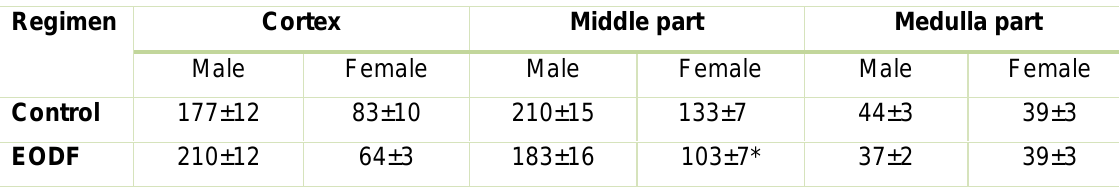
Table 1: The effect of every-other-day fasting (EODF) regimen on the activities of aconitase (mU/mg protein) in different parts of the brains of young mice